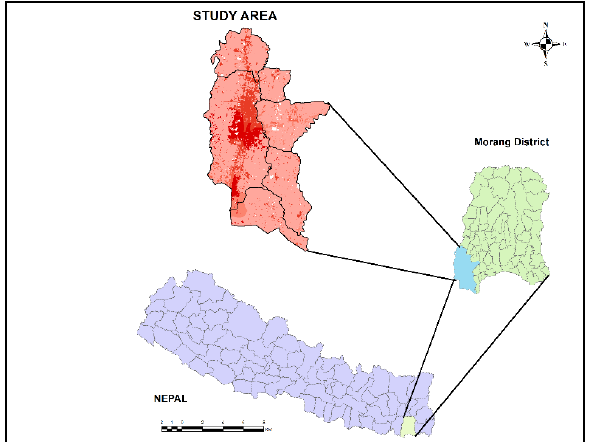
Figure 1. Location map of study